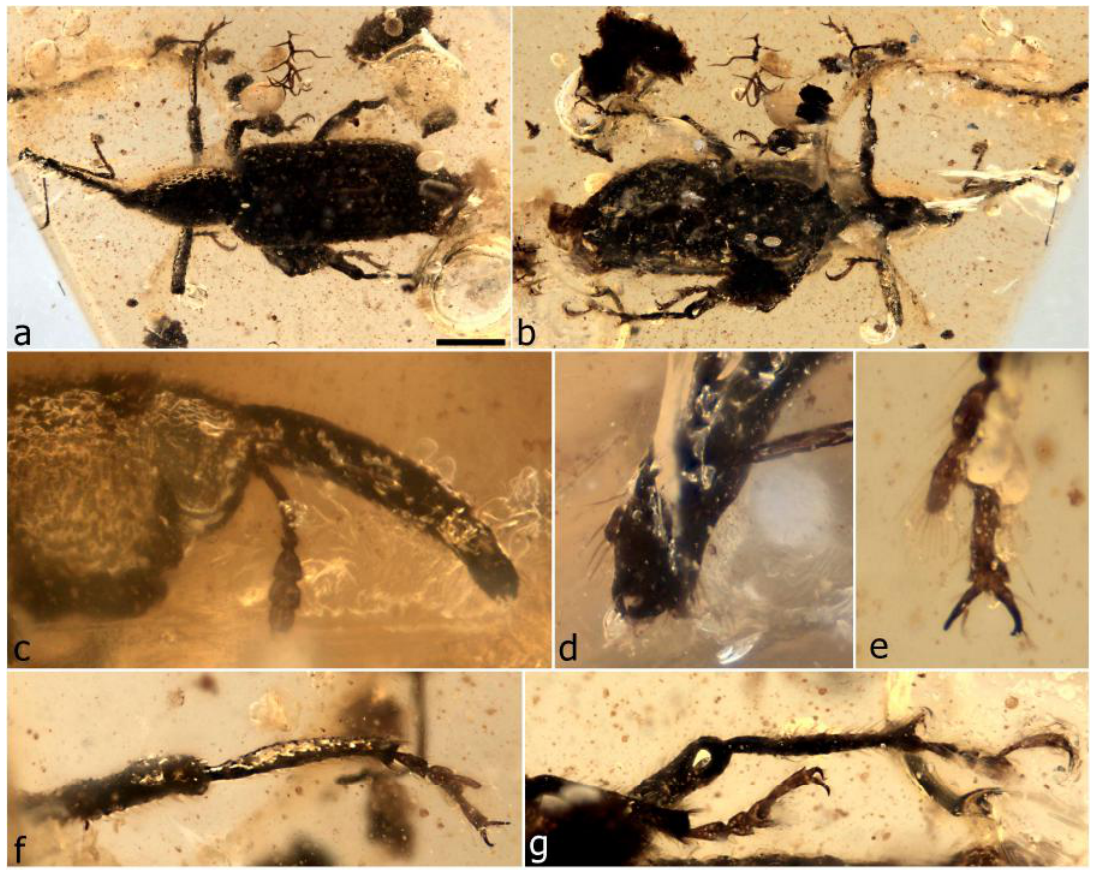
Figure 52. Rhadinomycter perplexus sp. n., holotype. Habitus, dorsal (rostrum appearing longer in this image due to a visual artifact caused by the angle of the block surface) ( a ); habitus, ventral ( b ); head and prothorax, right lateral ( c ); apex of rostrum and mandibles, dorsolateral ( d ); protarsus, dorsal ( e ); front leg ( f ); left meso-and metatibia ( g ). Scale bars: 1.0 mm (a). Genus Gnomus Clarke & Oberprieler, gen. n.